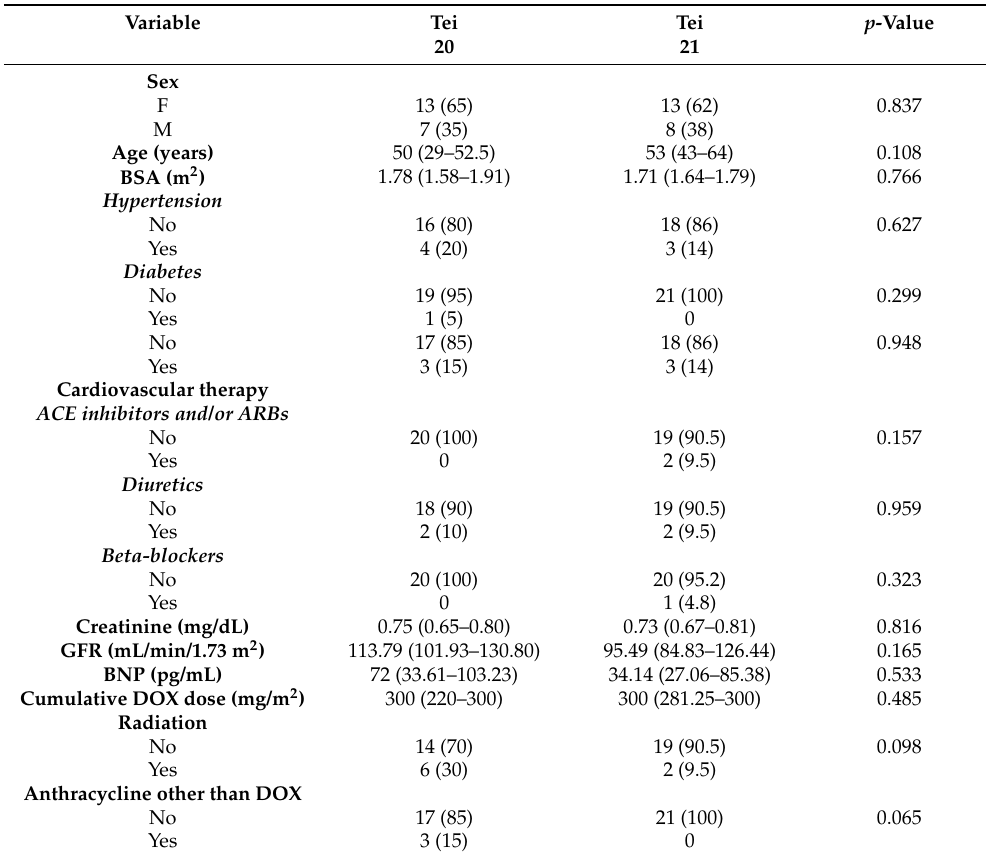
Table 2. Baseline characteristics in Tei- and Tei+ patients.